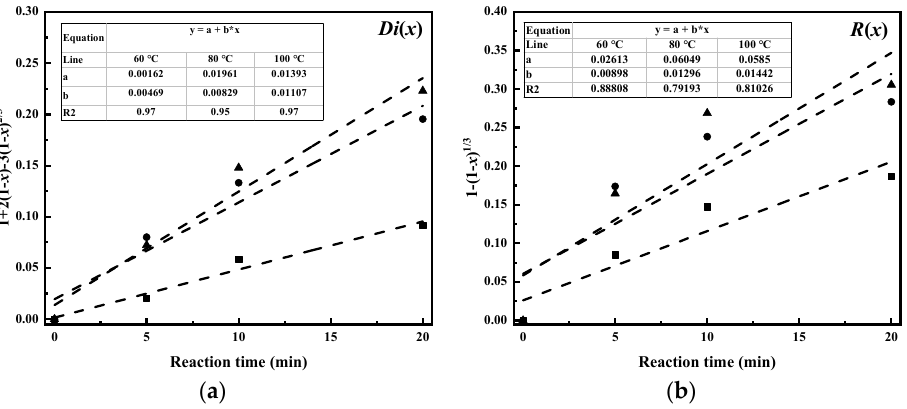
Figure 10. Fitting results of ( a ) —internal diffusion ( Di ( x )) and ( b ) —chemical reaction ( R ( x )) governing equations.